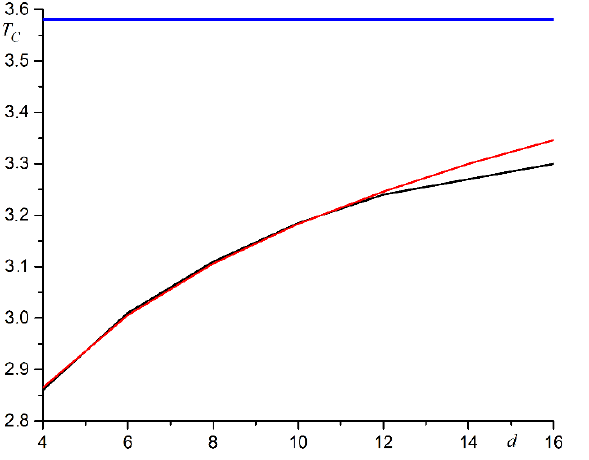
Figure 2. The dependence of the Curie temperature T C on the antidotes lattice period d with the hole size a = d /2. The black line is the result of a computer experiment. A red line approximates a logarithmic function. The blue line is the Curie temperature for a continuous film.